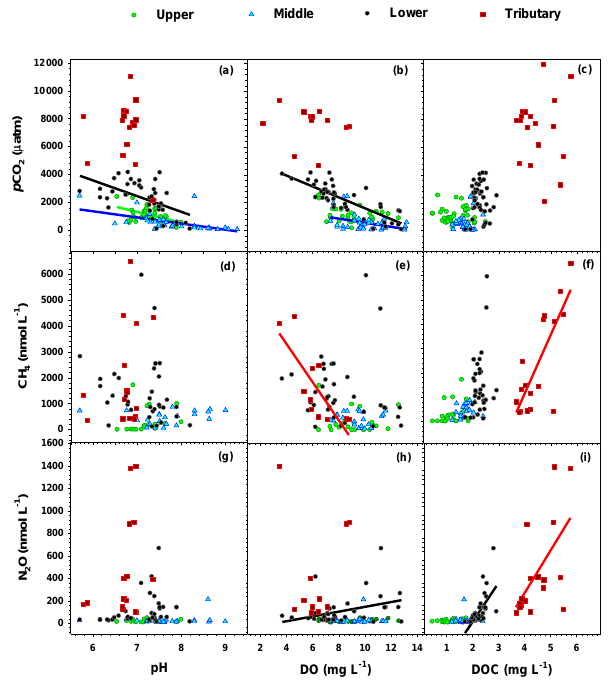
Figure 4. Relationships between water quality (pH, DO, and DOC) and dissolved concentrations of the three GHGs ( p CO 2 , CH 4 , and N 2 O) measured in the Han River basin. Regression analysis was conducted with data aggregated for each of the upper, middle, and lower reaches, and the group of the three urban tributaries (TC, JN, and AY). Only significant ( P < 0 . 05) relationships are indicated by the regression line through the